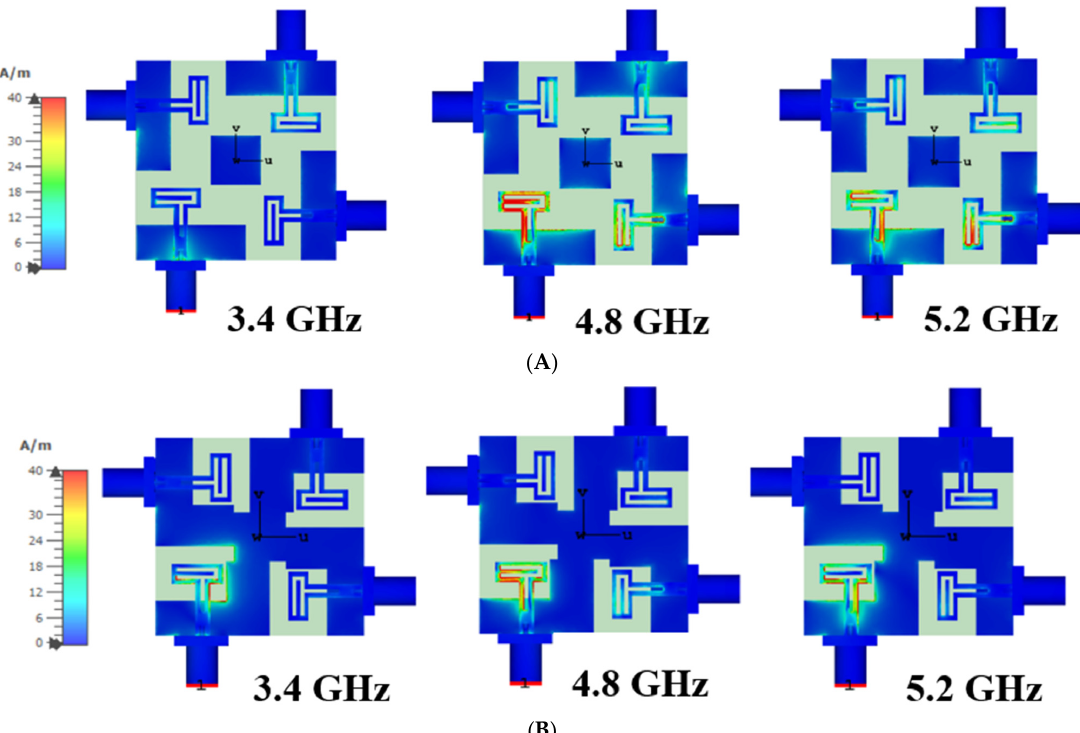
Figure 10. Current distributions in 3.4 GHz, 4.8 GHz and 5.2 GHz. ( A ) Step 2 design antenna; ( B ) final proposed antenna.